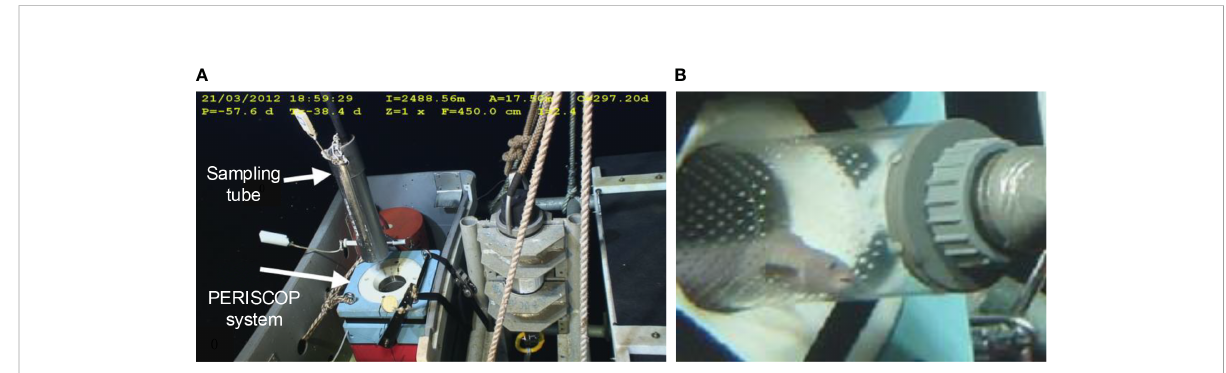
FIGURE 9 Photos of PERISCOPE (A, B) : the sampling tube is placed into the pressure vessel of the PERISCOP (adapted from Shillito et al., 2008; Ravaux et al., 2013) Zaharina et al. (2020) proposed a large-scale deep-water trap whose working depth is